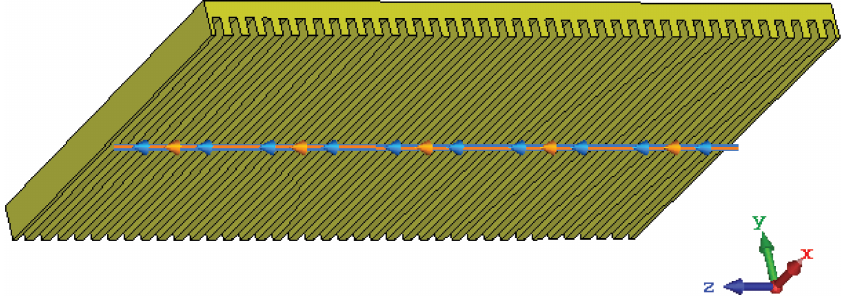
FIG. 9. Model used in the single-plate, numerical (CST S TUDIO ) calculations. The line and symbols indicate the beam trajectory. The plate width is w ¼ 12 mm, and, nominally, the beam offset is b ¼ 0 . 25 mm.